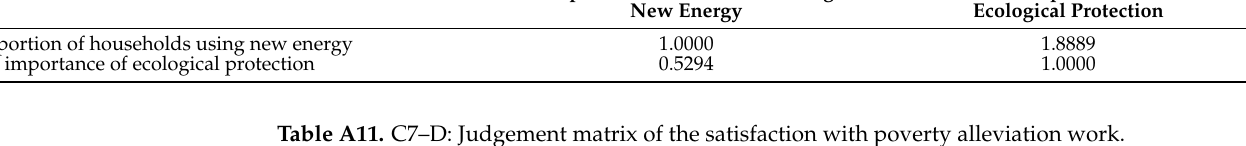
Table A11. C7–D: Judgement matrix of the satisfaction with poverty alleviation